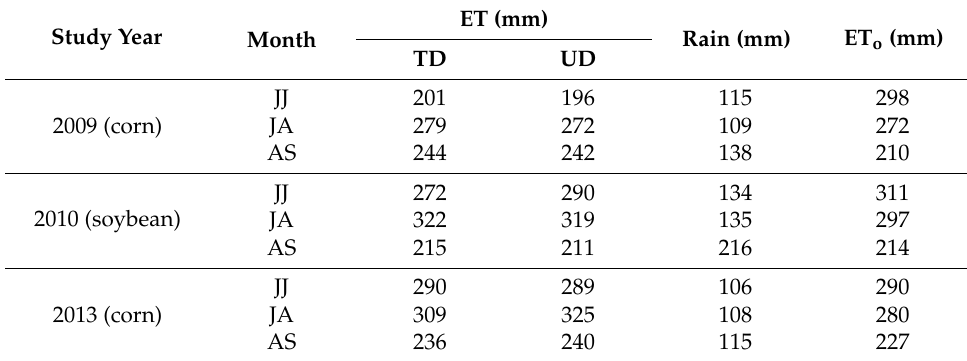
Table 3. ET from the subsurface drained (TD) and undrained (UD) field, rainfall, and reference ET